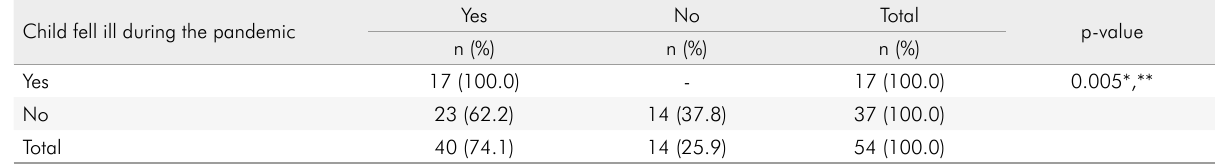
Table 5. Presence of symptoms according to the parents regarding the occurrence of disease. Child fell ill during the pandemic